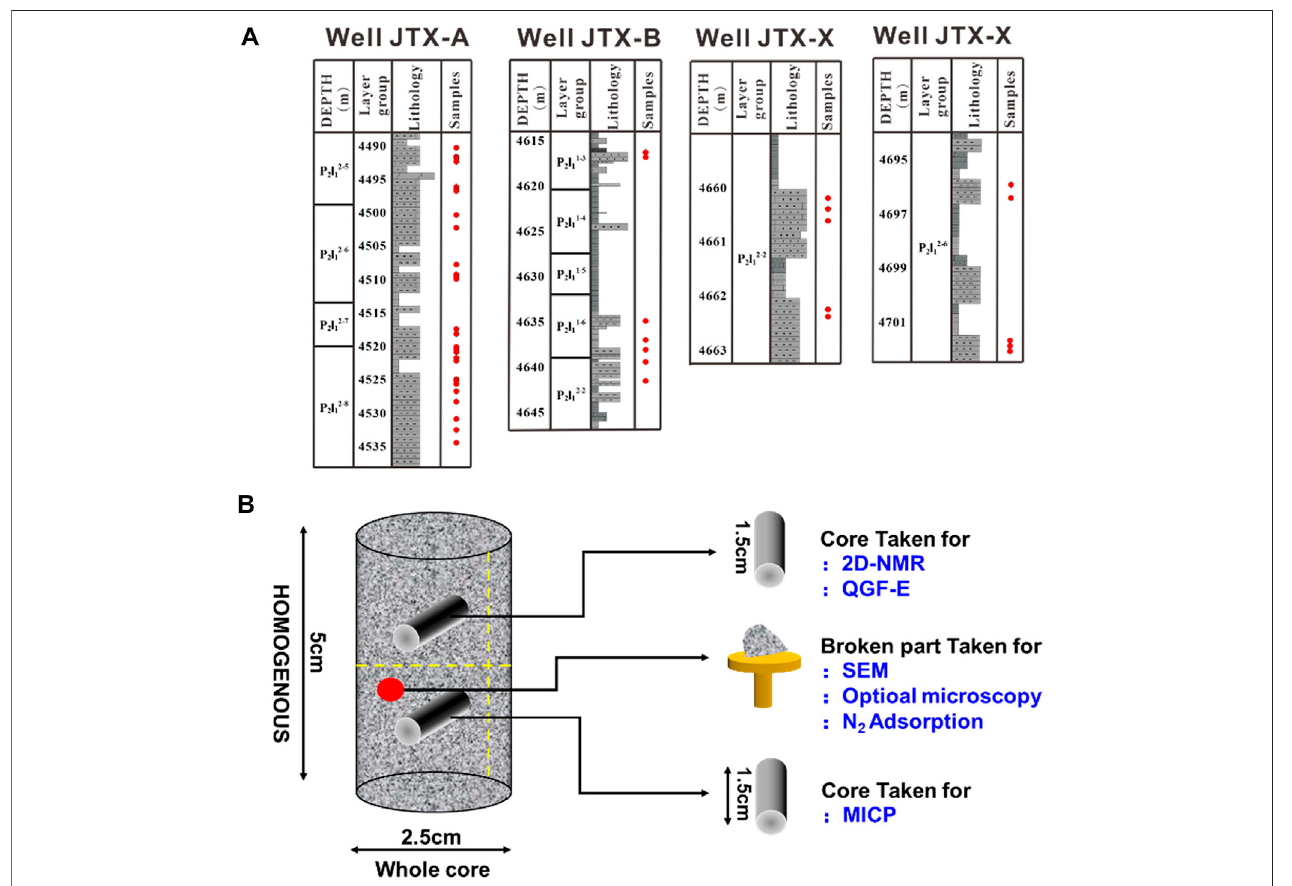
FIGURE 2 | (A) Sample location within each well; (B) Schematic diagram of sample processing.